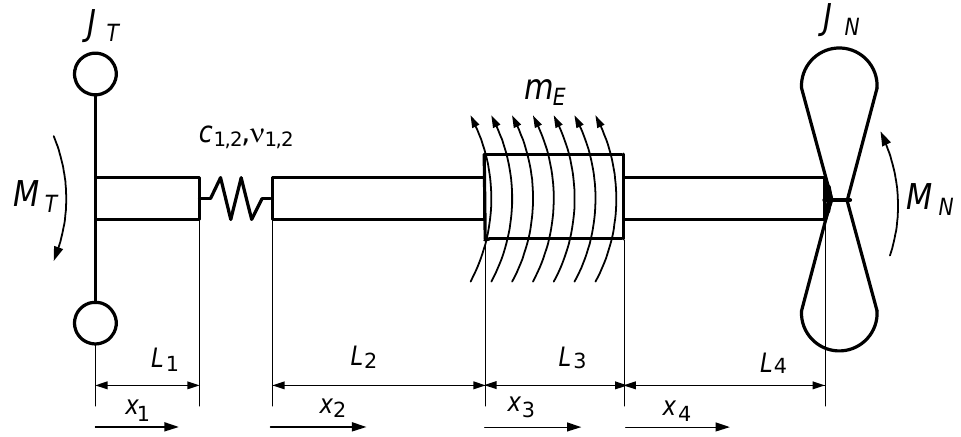
Figure 2. Kinematic diagram of motion transmission in the propulsion of the ship. The following symbols are used in Figure 2: M T is torque of the drive engine including gearing, M N is load torque of the propulsion, m E is distributed electromagnetic torque of the shaft generator, J T is moment of inertia of the drive engine including gearing, J N